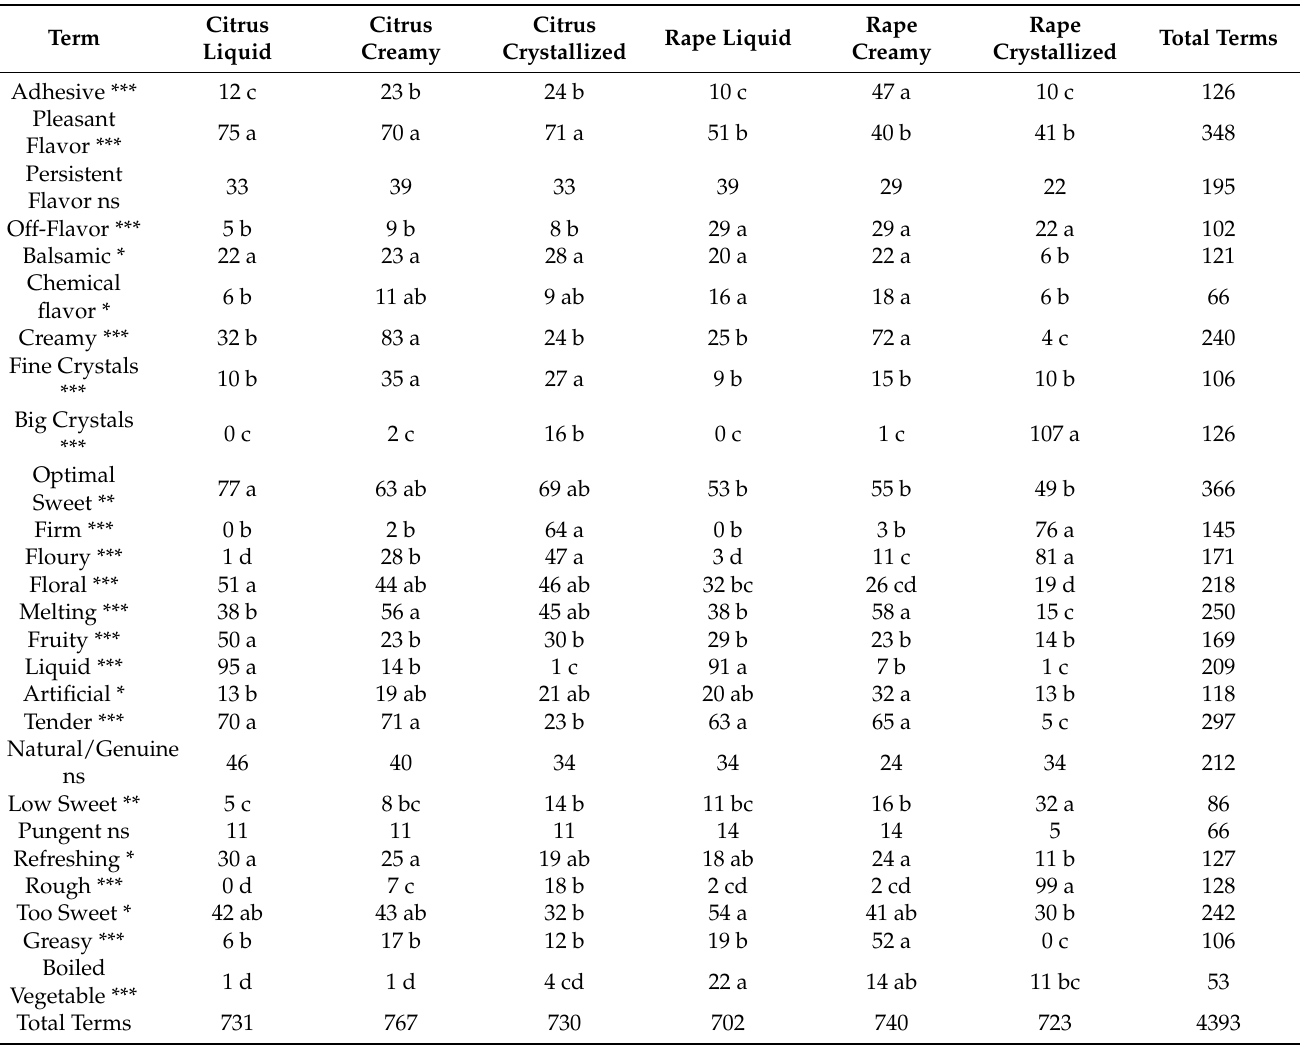
Table 13. Cochran’s Q tests for the citation frequencies of the gustatory CATA